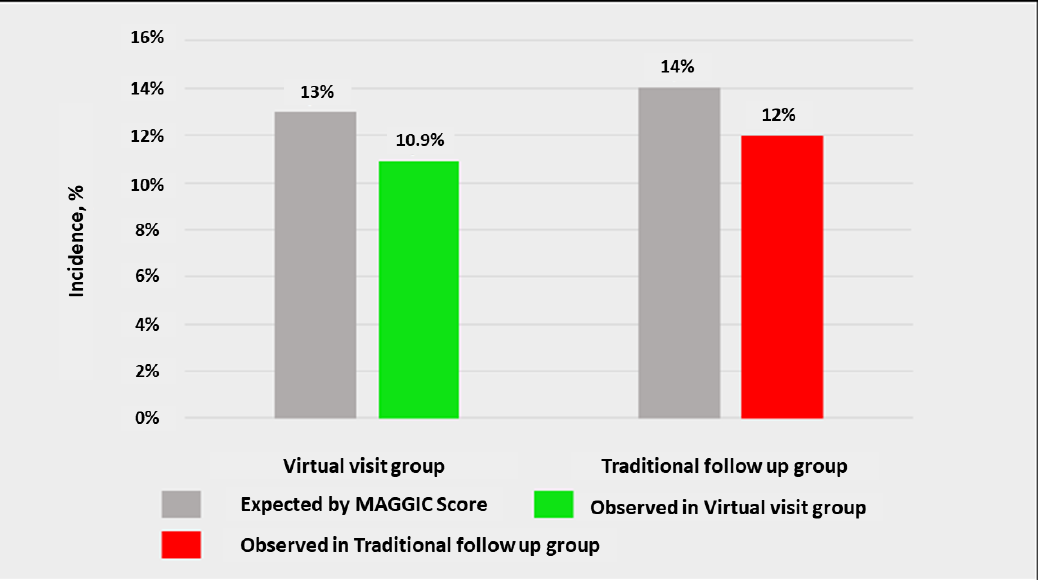
Figure 4. Comparison between expected and observed mortality, assessed through the Meta-analysis Global Group in Chronic Heart Failure (MAGGIC) score, between the two groups.